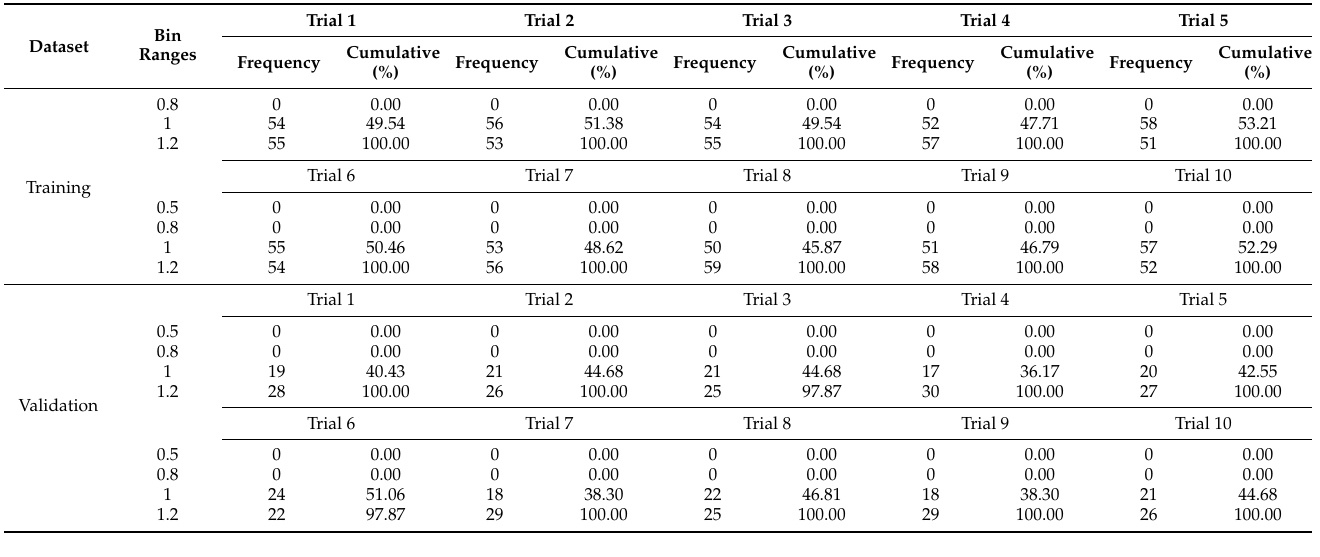
Table 7. Histogram analysis of predicted to experimental ratios ( ρ ) to determine CS 28 for all the 10 GEP trials undertaken in the current study.